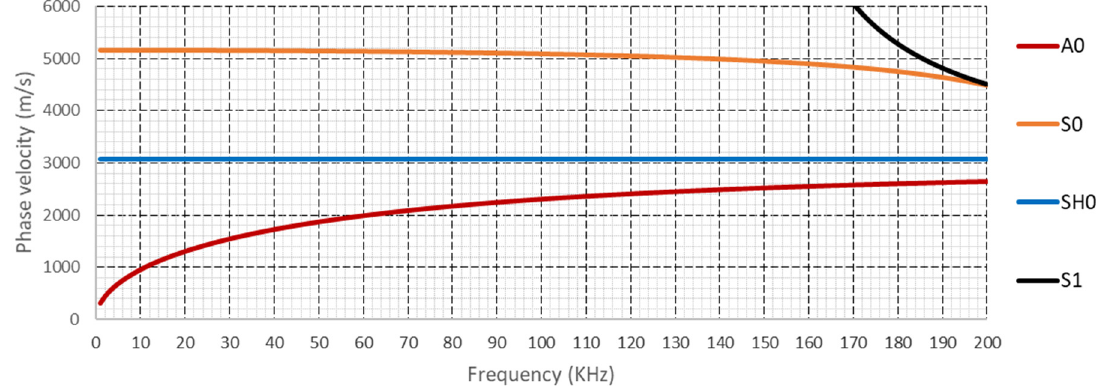
Figure 3. Phase velocity dispersion curves for U-pile.